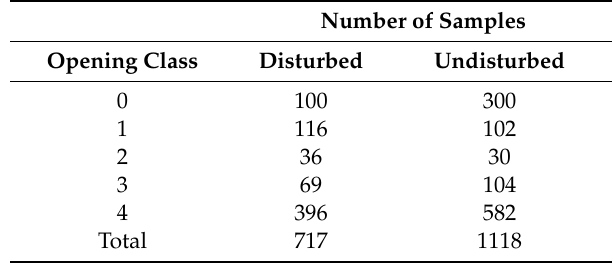
Table 2. Distribution of validation samples across opening size class and disturbance regime. Equation (1) suggested higher values for Class 0 (both in disturbed and in undisturbed areas) and a smaller number for Class 2 in undisturbed areas. All three values were adjusted for feasibility and statistical robustness,